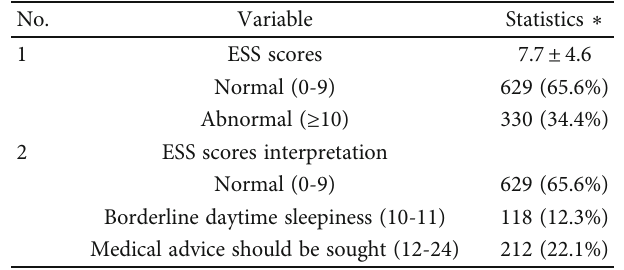
Table 1: Participant ’ s demographic pro fi le (n =986). Table 2: ESS scores values and their